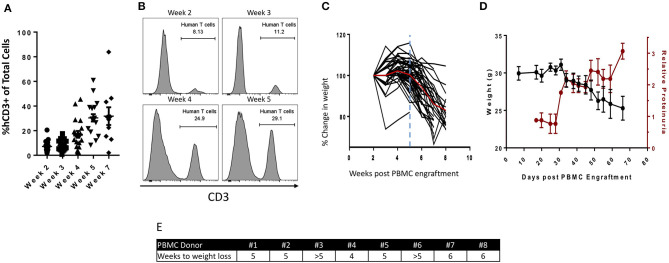
Characterization of the PBMC humanized NSG-β2m−/− mouse model. 1 ×107 human healthy donor PBMCs were injected i.p. into NSG-β2m−/− mice at day 0. (A) Animals were bled weekly with circulating lymphocytes isolated and immunostained for human CD3. Graph depicts frequency of human CD3+ cells of total live circulating cells at weeks 2–7 post-PBMC engraftment (n = 19; week 7, n = 10; data reported as mean ± SEM). (B) Histograms from animals representing the frequency of circulating human T cells at weeks 2, 3, 4, and 5. (C) Percent change in humanized mouse body weight from the time of initial PBMC engraftment (n = 50); vertical blue line indicates the timepoint prior to the development of overt GvHD, red line denotes mean change in animal weight. (D) Parallel changes in body weight vs. relative proteinuria. (E) PBMC donor-dependent difference in the reduction of body weight post-PBMC engraftment.